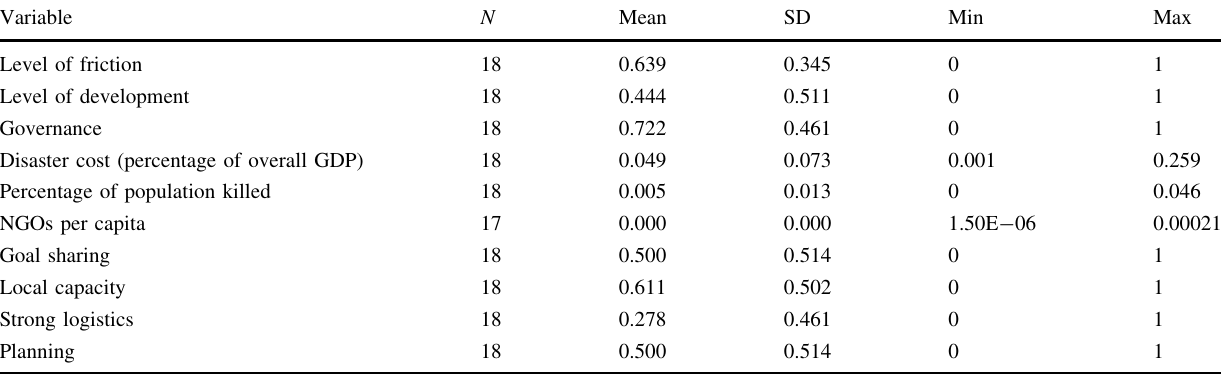
Table 1 Descriptive statistics for 18 disaster events in the Americas, Asia, and East Africa Variable N Mean SD Min Max Level of friction 18 0.639 0.345 Level of development 18 Governance 18 Disaster cost (percentage of overall GDP) Percentage of population killed 18 NGOs per capita 17 Goal sharing Local capacity